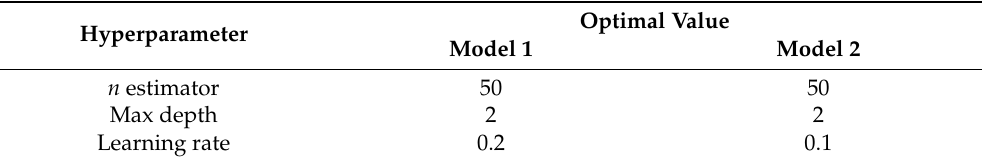
Table 4. Hyperparameters of the model’s optimization.